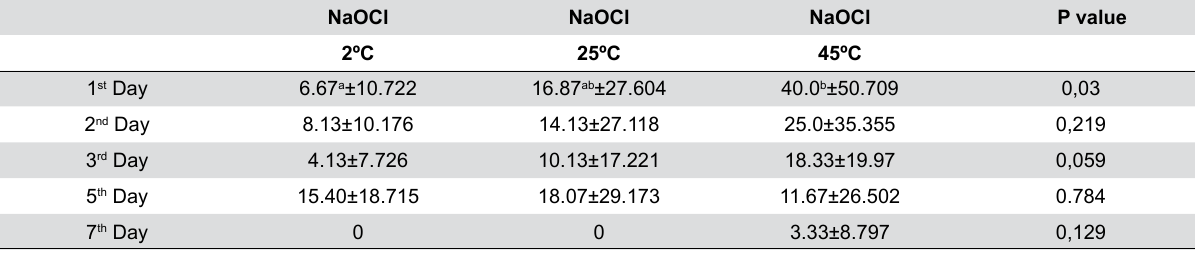
Table 5- Postoperative pain levels according to the